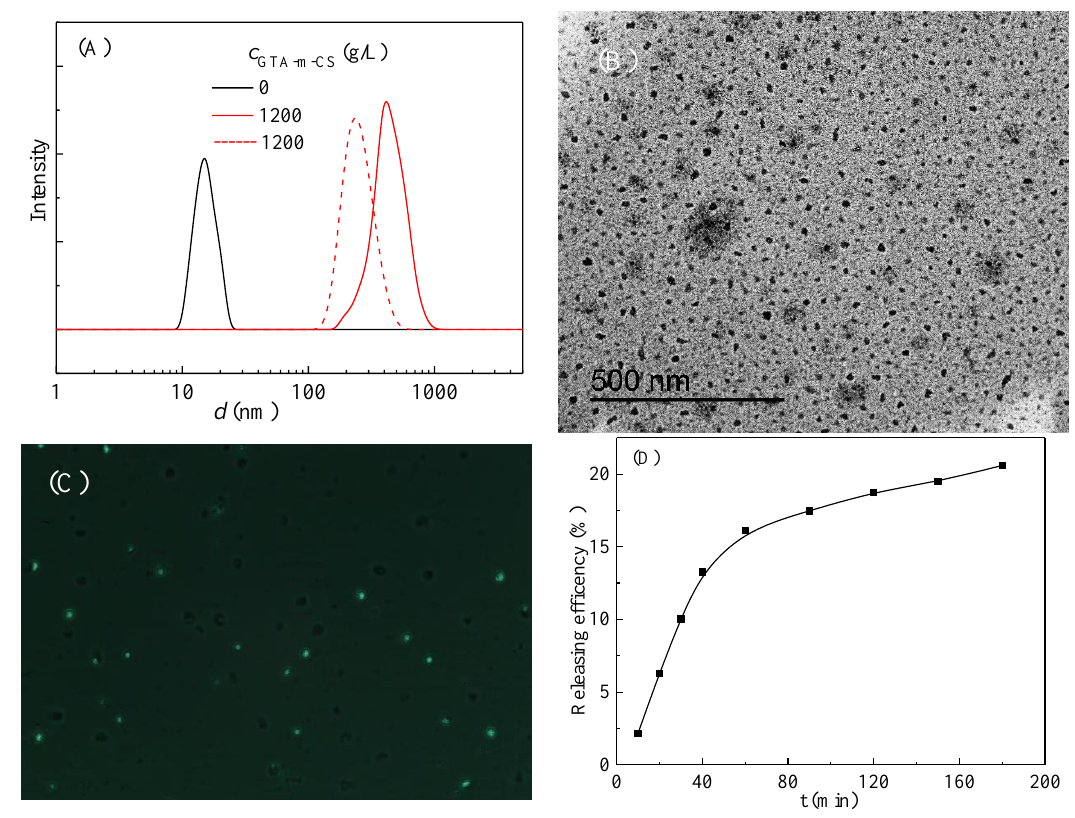
Figure 6. Hydrodynamic radius ( A ), TEM images ( B ), fluorescence confocal micrograph ( C ) and curcumin-releasing behavior ( D ) of curcumin-loaded DDEAC and GTA-m-CS/DDEAC micelles.